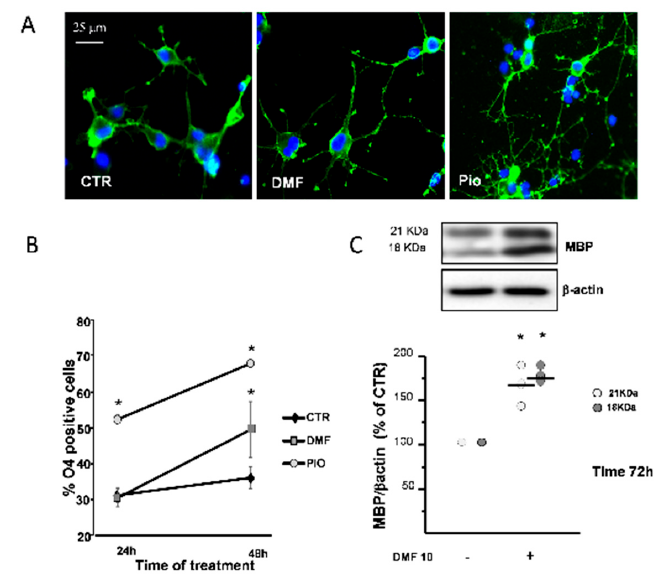
Figure 6. DMF and pio differently promote OP differentiation. OP cultures treated for 24 or 48 h with 10-µM DMF or 1-µM pio were immunostained for O 4 ( A ). The % of O 4 -positive cells was calculated, and mean ± SEM are shown in the graph ( B ) ( n = 5 to 6 experiments; * p < 0.05 vs. CTR). OP cultures were treated for 72 h with DMF 10 and then processed for WB of the myelin basic protein (MBP) and β -actin ( C ). Representative bands of β -actin and MBP at the two different molecular weights (18 and 21 kDa) are shown above. Mean ± individual data points from the densitometric analysis are shown in the bar graph below ( n = 3; * p < 0.05 vs. CTR).